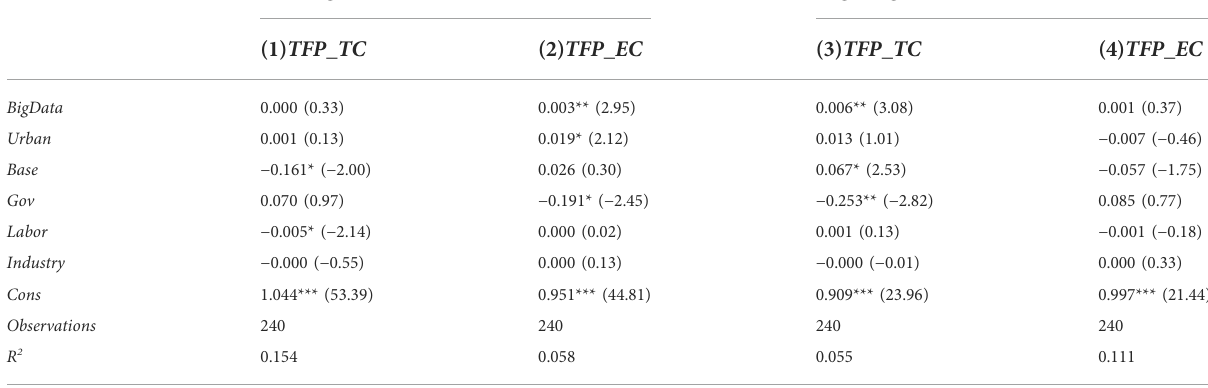
TABLE 7 Empirical results of digital fi nancial inclusion heterogeneity.